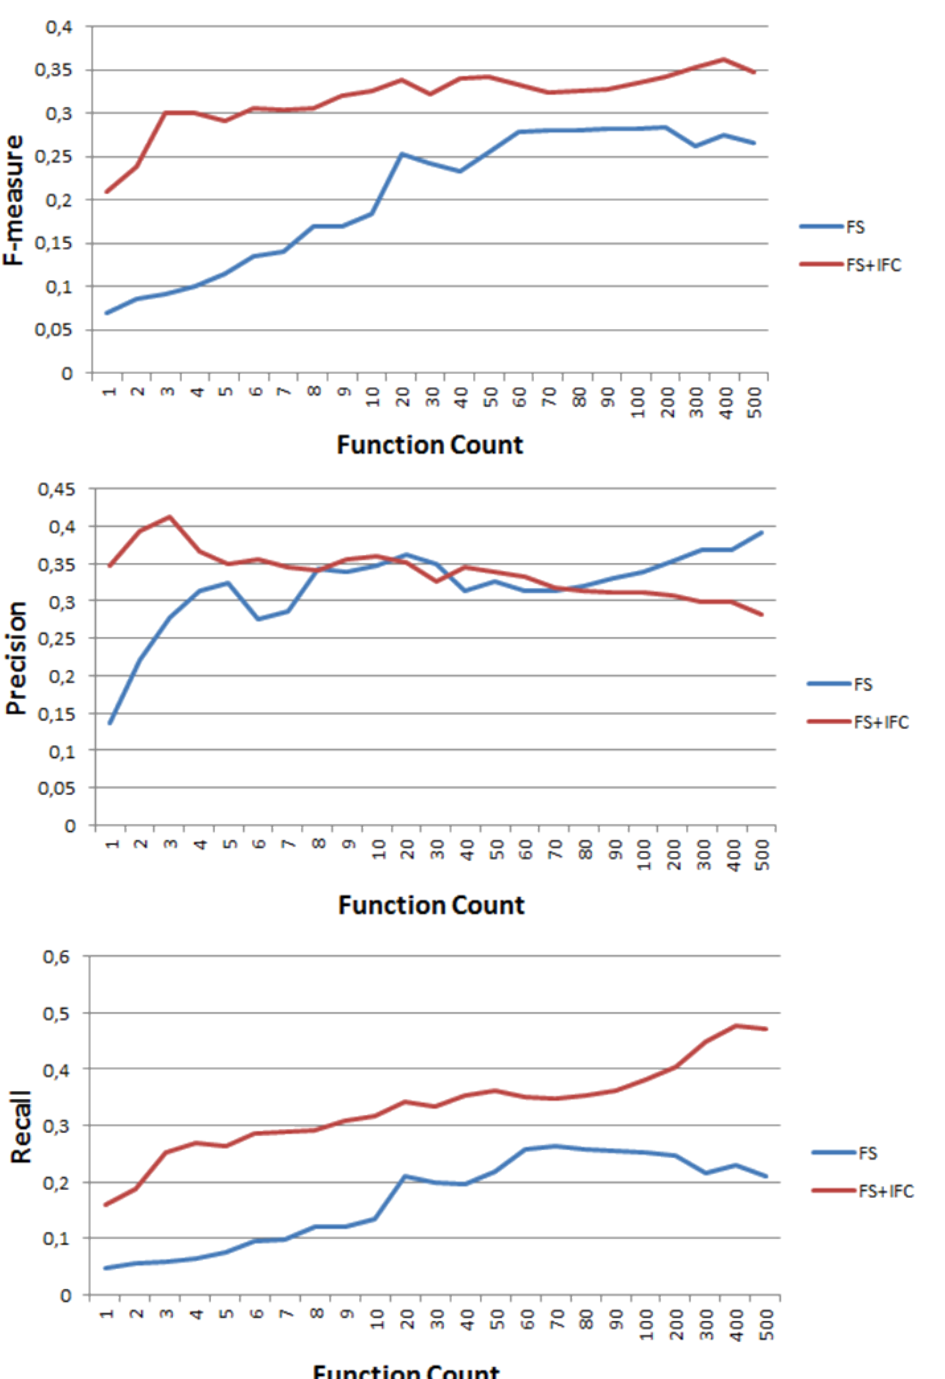
Figure 1: Comparing different Functional Context methods. The FS + IFC method always outperforms the FS method with respect to